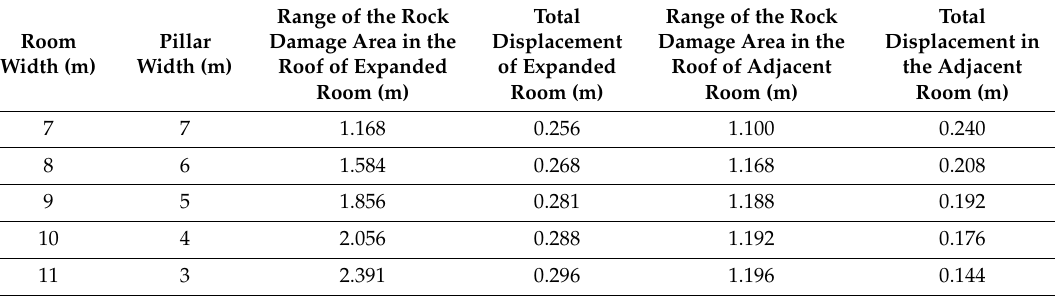
Figure 14. Part of the rock mass model with marked variable room and pillar width: Cs—compressive strength; γ —bulk density; E—Young’s modulus; ν —Poisson’s ratio. Table 2. Summary of numerical modeling for expanded